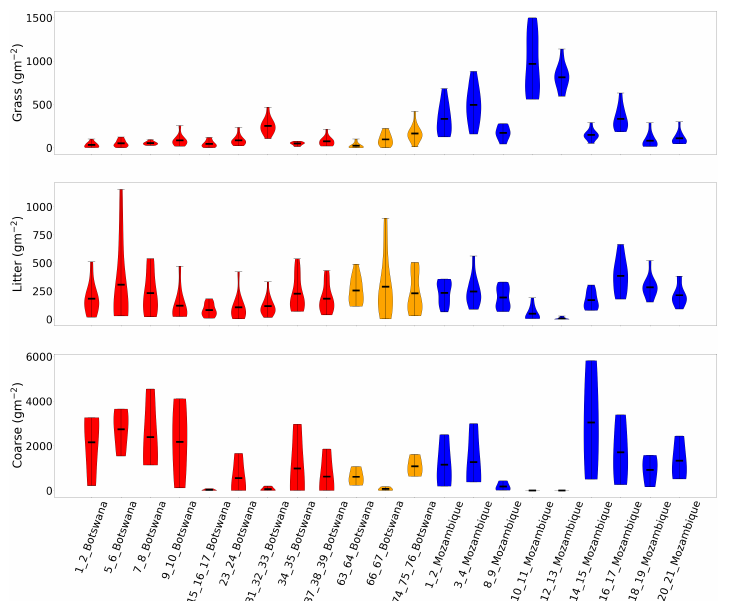
Figure A1. Site distribution of fuel load across grass, litter and coarse categories. Red indicates a site in Tsodilo in the EDS, orange in Tsodilo in the LDS, and blue a site in Niassa.